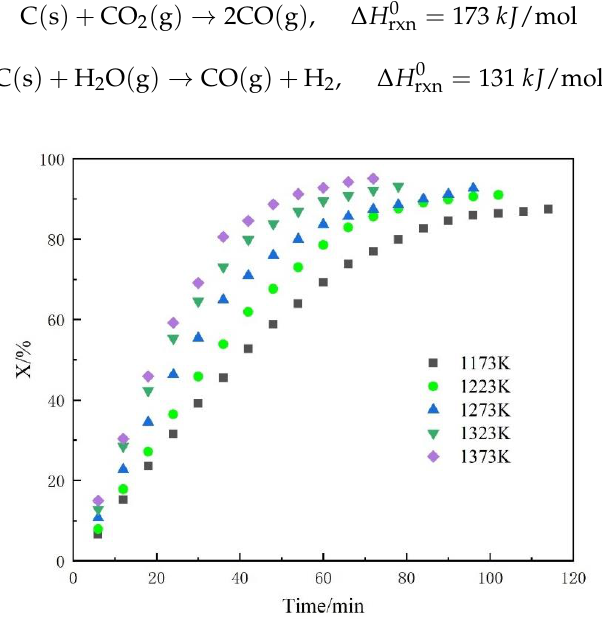
Figure 2. Isothermal gasification curves of bituminous coal char in the temperature range 1173–1373 K with intervals of 50 K in the mixture of CO 2 , H 2 O, CO, H 2 , and N 2 atmosphere. On the basis of Equations (3) and (4), Figure 3 shows the kinetic results of bituminous coal char gasification at different temperatures under the mixture of CO 2 , H 2 O, CO, H 2 , and N 2 atmosphere. Obviously, the entire gasification process has two stages: the early stage and the later stage. At the early stage, the straight lines’ correlation coefficients (R 2 ) for the above mixture components are 0.995, 0.995, 0.985, 0.989, and 0.990, respectively, while at the later stage, the straight lines’ correlation coefficients (R 2 ) are 0.997, 0.979, 0.989, 0.994, and 0.989, respectively. Thus, from the linear relation,